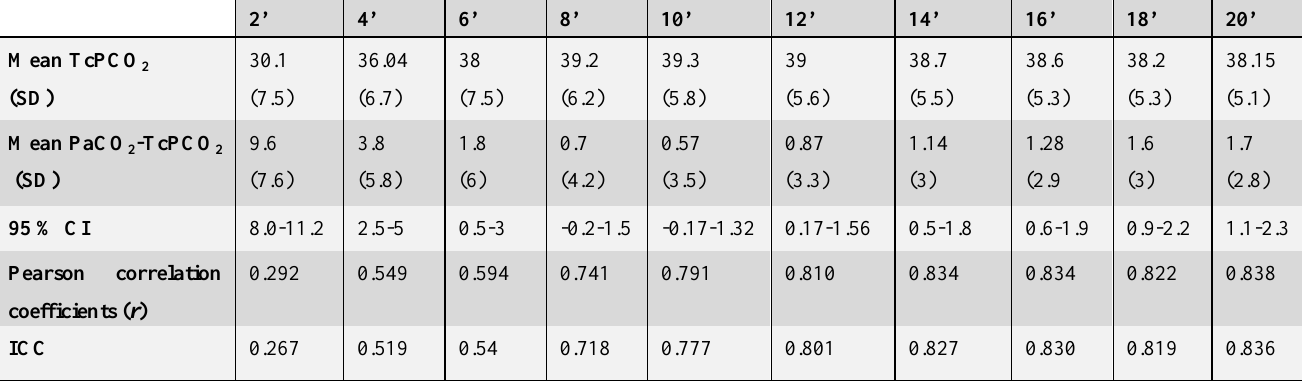
Table 2 . Values of TcPCO correlation and intraclass correlation coefficient for individual measures each 2